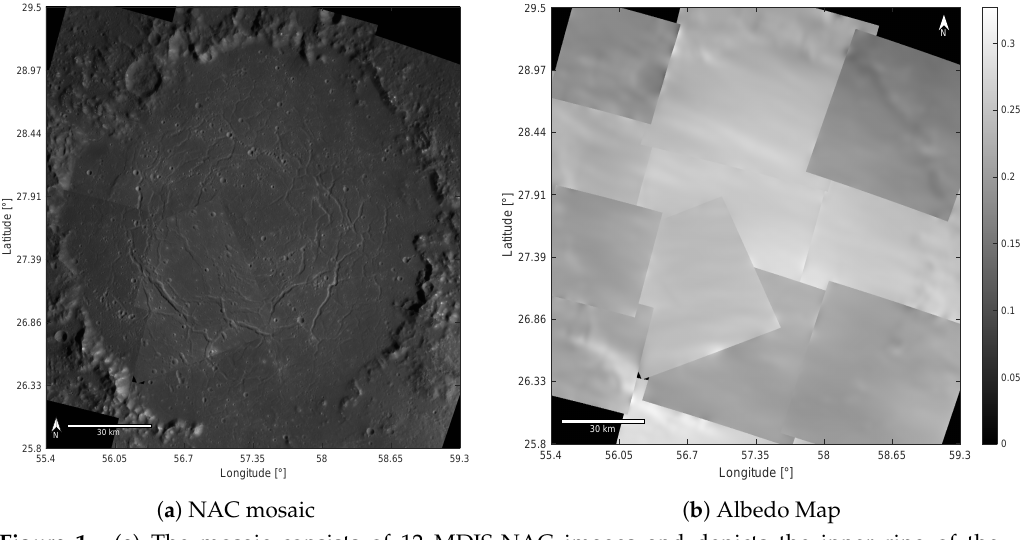
Figure 1. ( a ) The mosaic consists of 12 MDIS-NAC images and depicts the inner ring of the Rachmaninoff basin. ( b ) Albedo map of the inner ring of the Rachmaninoff basin with tile-wise albedo estimation. The boundaries between the individual tiles become more pronounced the more different the lighting conditions are.